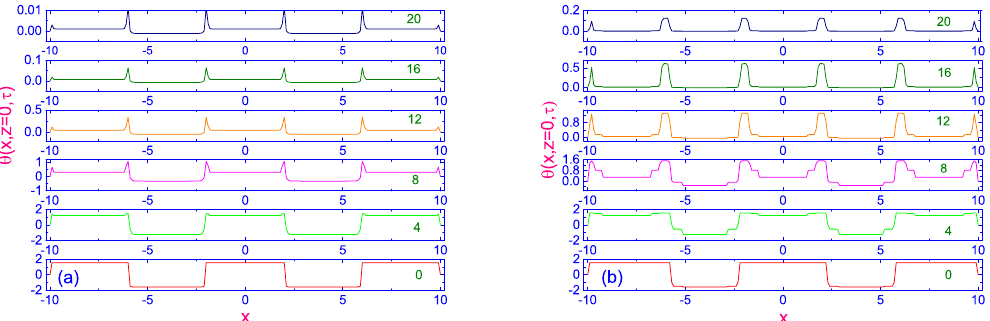
Figure 11. Plot of the evolution of the polar angle θ ( x,z = 0, τ ) to its equilibrium distribution along the length of the dimensionless nematic film ( − 10 ≤ x ≤ 10 ) and for a number of dimensionless times τ = 2 (22), 6 (26), 8 (28), 12 (32) and 20 (40) [17], respectively. ( a ) shows the case B, while ( b ) shows the case A, respectively, during the turned-off process (E =